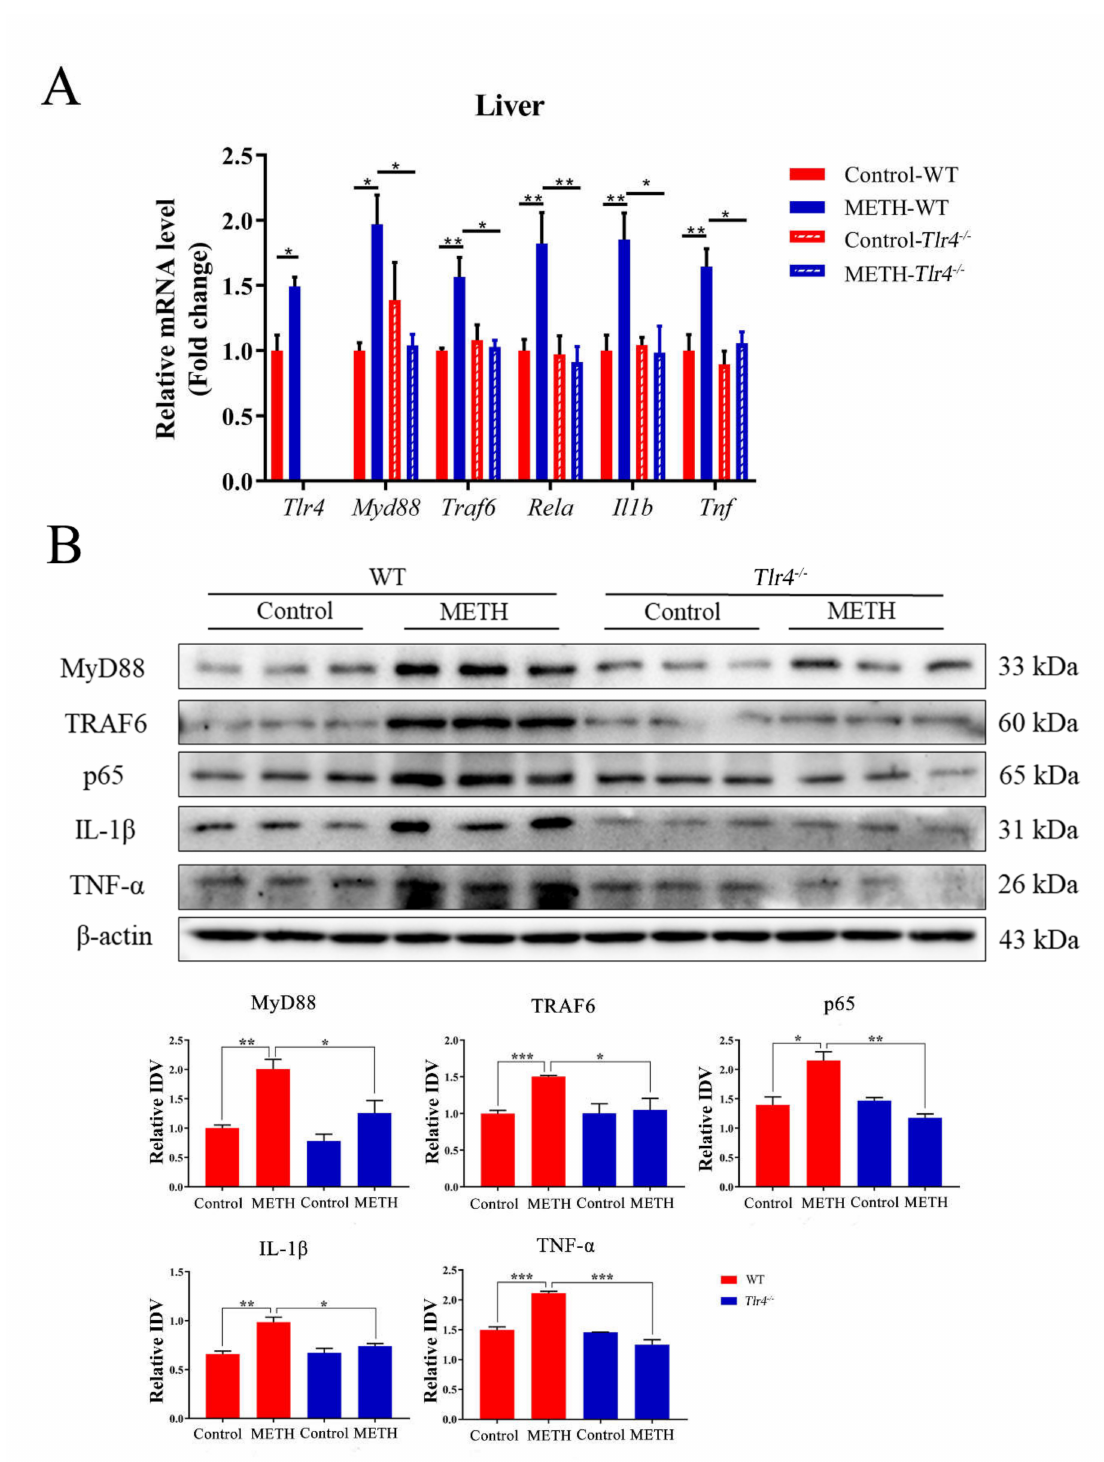
Figure 5. Expression of MyD88, TRAF6, p65, IL-1 β , and TNF- α at mRNA and protein levels in mouse liver. ( A ) Relative mRNA expression of Tlr4 , Myd88 , Traf6 , Rela ( p65 ), Il1b and Tnf in wild-type and Tlr4 − / − mice; ( B ) Protein expression of MyD88, TRAF6, p65, IL-1 β and TNF- α in mouse liver. * p < 0.05, ** p < 0.01, *** p <